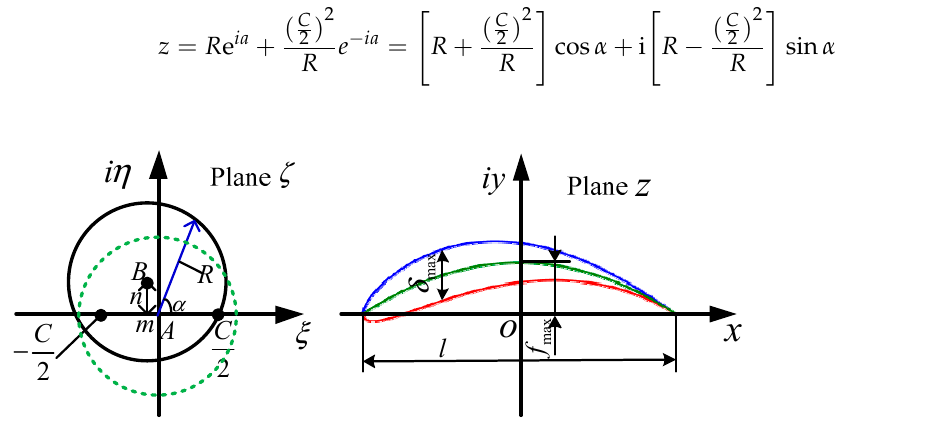
Figure 1. Joukowski